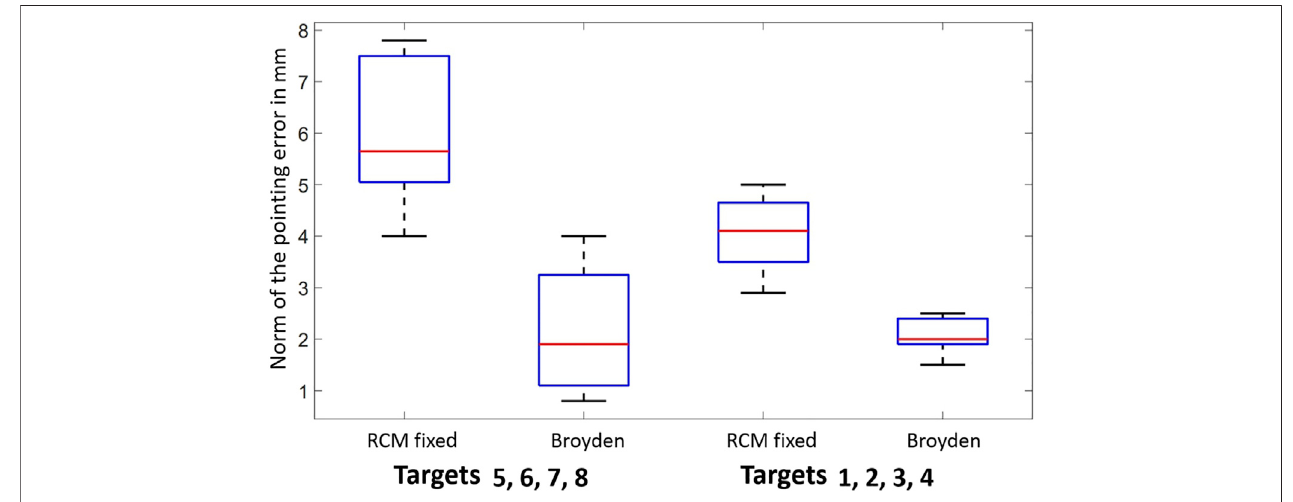
FIGURE 11 | Average error of the scoring task with the RCM Fixed model and the Broyden